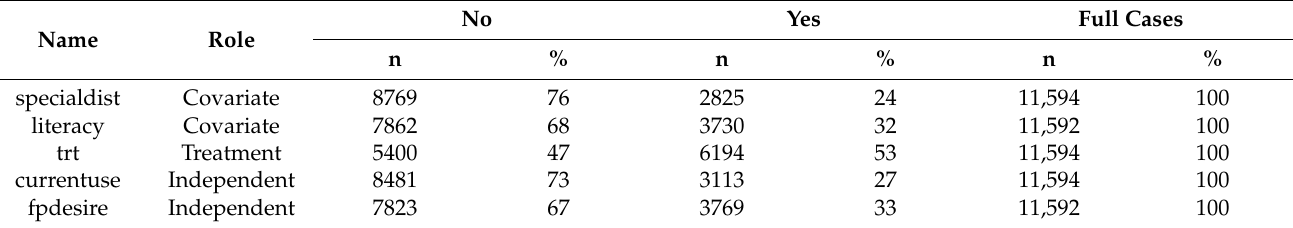
Table 2. Binary covariates and variables of interest (Liberia 2013; Ghana 2014; Senegal